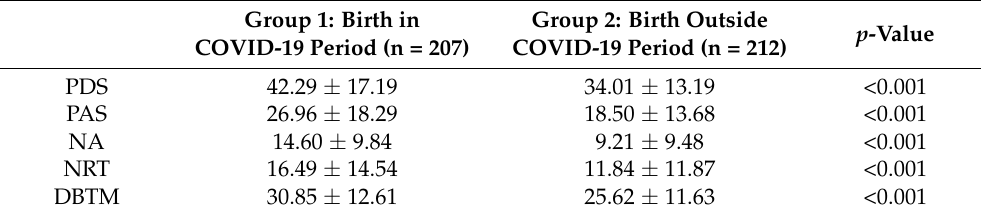
Table 4. Comparison of depressive and anxiety symptomatology, negative affect, negative repetitive thinking, and dysfunctional beliefs towards motherhood scores between Group 1—Mothers who gave birth in COVID-19 period, and Group 2—Mothers who gave birth outside COVID-19 period— Students t -Test.